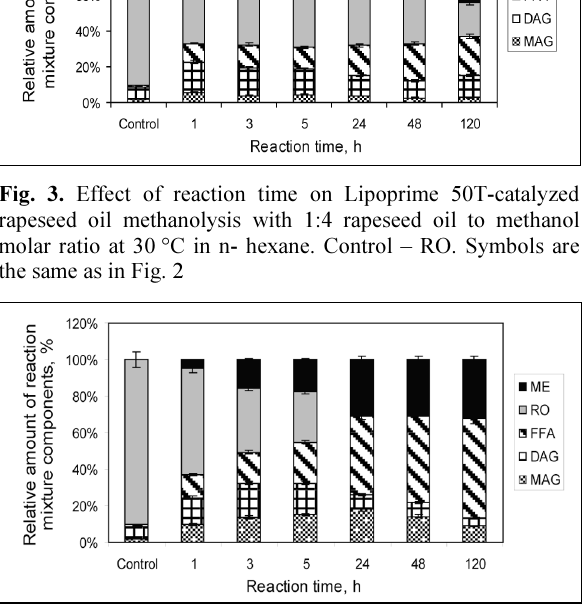
Fig. 5. Thin layer chromatographic view of control samples (TAG – triacylglycerols, FFA – free fatty acids, DAG – diacyl- glycerols, MAG – monoacylglycerols)